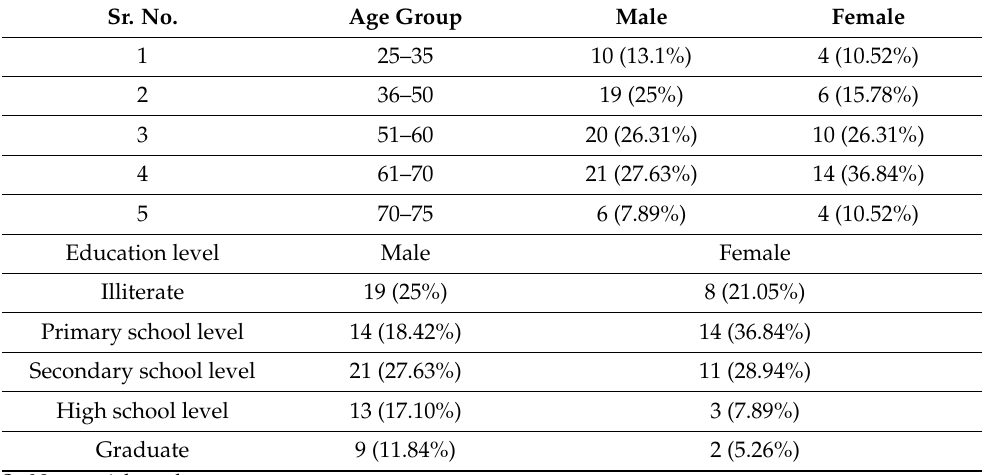
Table 1. People of different age groups were randomly selected for interviews. Sr. No.